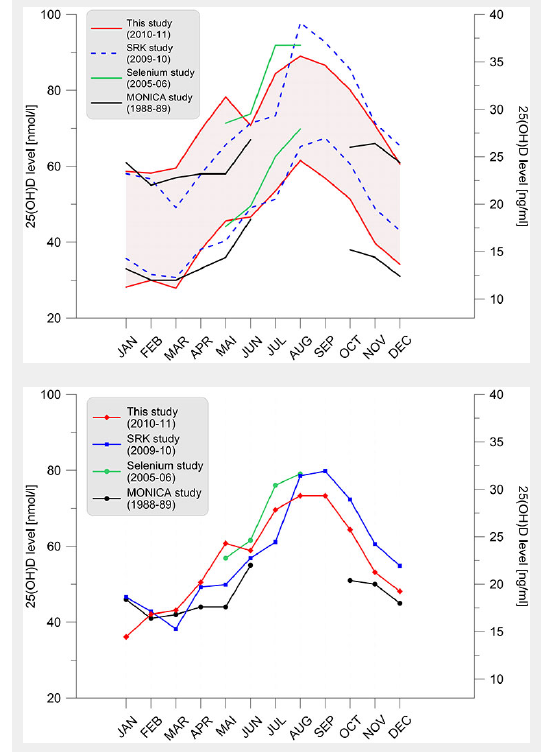
A Variation of the serum 25-hydroxyvitamin D distribution per month of examination for different studies. Lower and upper lines represent the 25th and 75th percentiles, respectively. The area between the 25th and 75th percentiles of our study is shaded (red) to enhance the readability of the data. Measured values are given in ng/ml (right axis) and nmol/l (left axis). Selenium and MONICA studies were not conducted over a full year and data points are therefore missing. B Variation of the serum 25-hydroxyvitamin D medians per month of examination for different